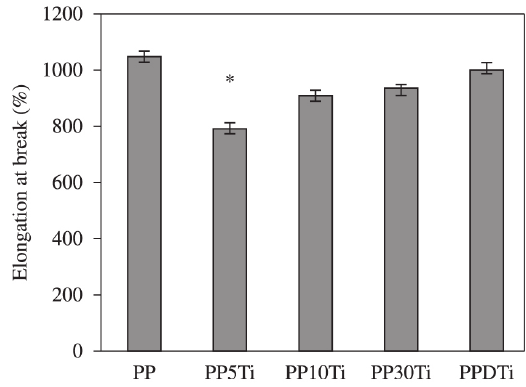
Figure 8. The elongation at break of the PP/TiO2 Nano-composites. *significantly different from pure P, (Unpaired Student’s t test, P <